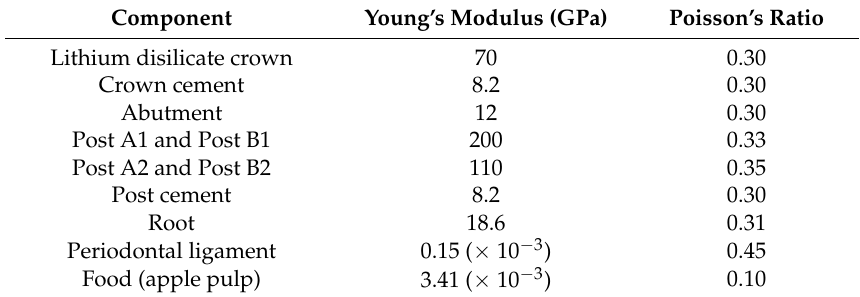
Table 1. Mechanical properties of the model components: Young’s modulus and Poisson’s ratio [4,11,13].